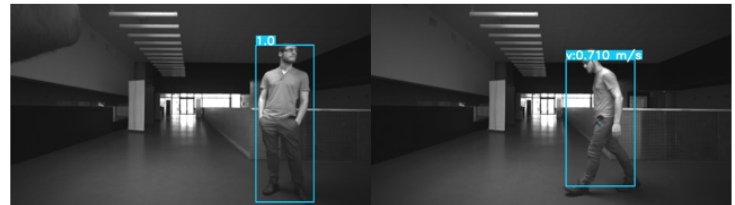
Figure 10. Result of the tracking approach over an indoor scene using the stereo images provided by the Intel RealSense D435 sensor. The left frame is acquired at instant t = 1 and the right one at the instant t + 3. At t = 1, we assign an ID to each detected object. Then, at t + 3, the tracklet is validated and we display the estimated speed.